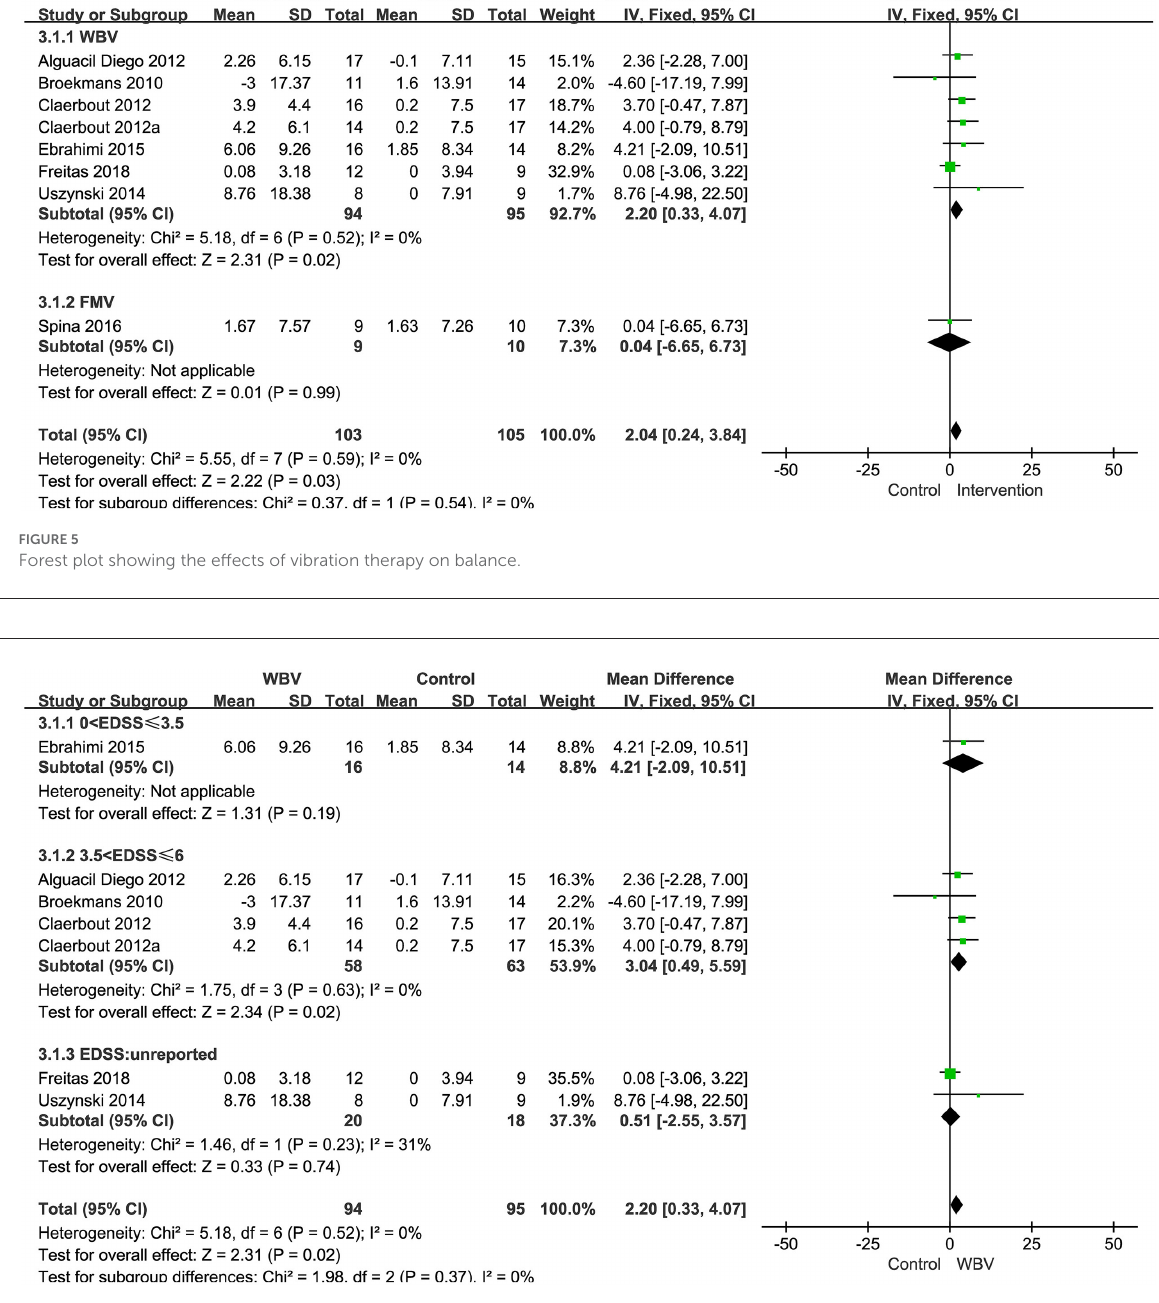
FIGURE6 Forest plot showing the effects of WBV on balance in subgroups stratified according to the EDSS